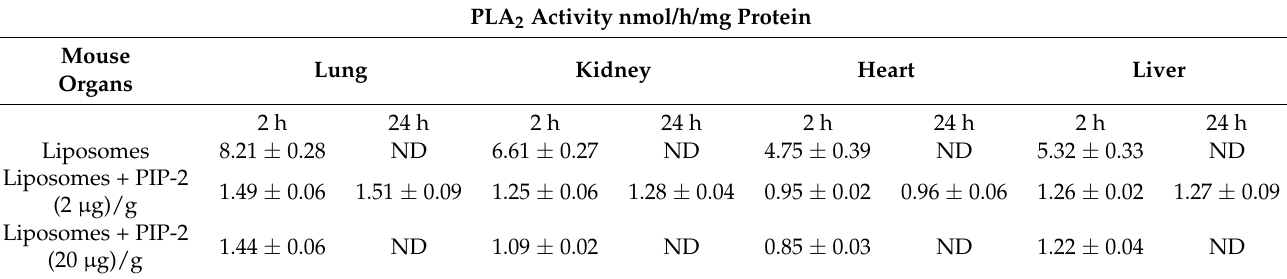
Table 1. Effect of PIP-2 on aiPLA2 activity of mouse organs.